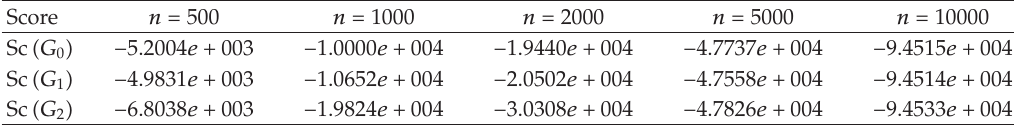
Table 2: Scores on Alarm for di ff erent dataset size n : score of original network Sc (cid:2) G 0 (cid:3) , score of network returned by Algorithm 1 Sc (cid:2) G 1 (cid:3) , and score of network returned by K2 algorithm Sc (cid:2) G 2 (cid:3)